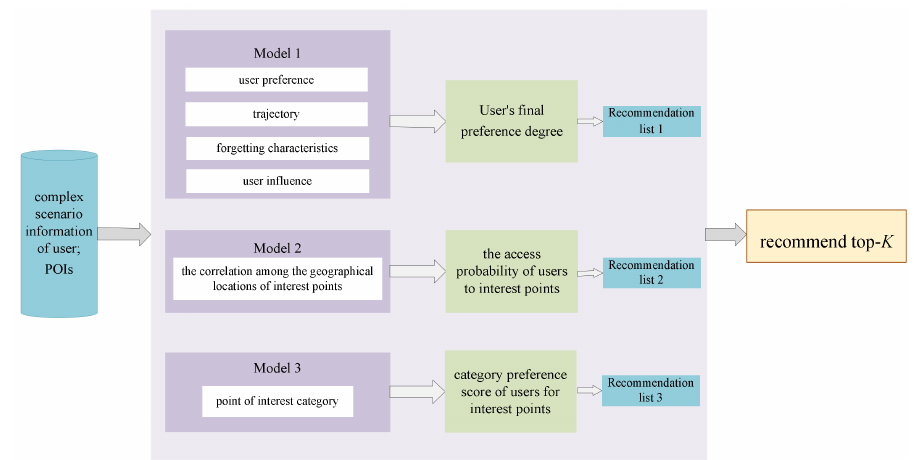
Figure 1. Framework of Hybrid Recommendation Model.